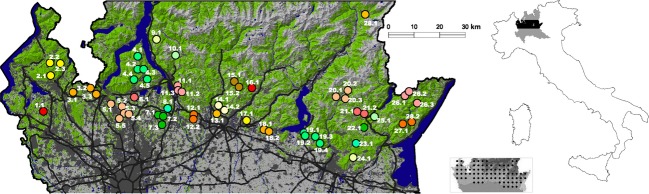
Study area colored according to land uses (left) and its geographical position within Italy (right): on the right, study area (black), within Lombardy (gray) in Northern Italy. On the left, forests in green, urban areas in dark–gray, farmland and other open habitats in gray, lakes, wetlands, and rivers in blue. Black lines represent main roads. Different colored dots represent sampling populations (SPs), while numbers refer to sampling locations (LOCPRIOR) with the first number indicating the SP which the sampling location pertain to. In the lower inset map, dots on the elevation map of the study area represent the Prealpine distribution of the Fire Salamander in Lombardy (the darker is the background, the higher is the elevation; from Di Cerbo and Razzetti 2004).